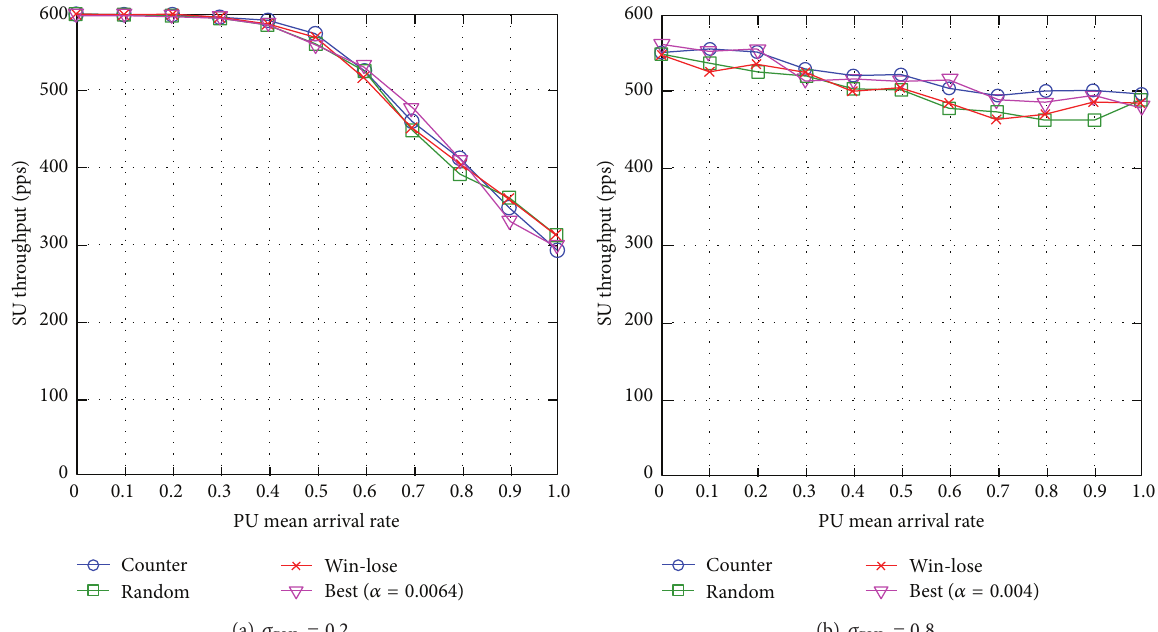
Figure 19: SU throughput for varying PU mean arrival rate 𝜇